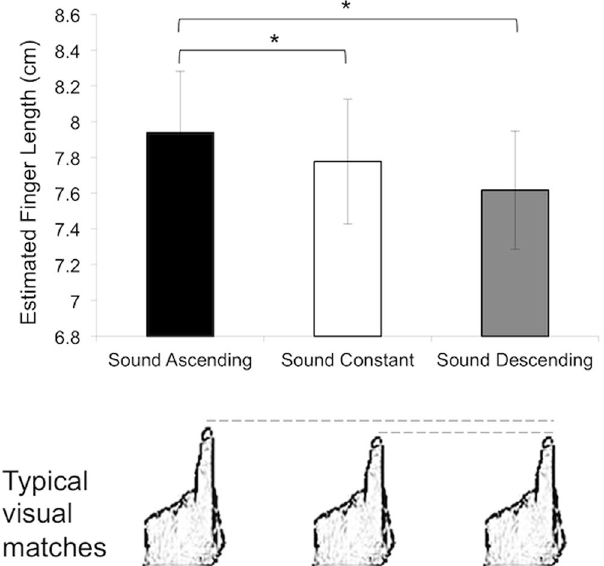
Figure 2. Results of Experiment 1: Mean ( ± s.e.m.) estimated finger lengths as a function of condition in Experiment 1 (N = 24). The asterisk indicates significant differences between sound conditions ( p < 0.05, corrected for multiple comparisons). Participants provided larger finger length estimates for the ‘ascending’ sound, compared with the ‘descending’ sound and with the ‘constant’ sound. The bottom panel displays finger drawings chosen by participants to describe the subjective feeling of their finger when listening to the sound (the drawing closest to the mean choice is displayed as a function of condition). Participants selected significantly longer visual matches to their index finger after the ‘ascending’ sound as compared to the ‘constant’ and ‘descending’ sounds. Drawings in bottom panel are reprinted from Current Biology, 15(14), de Vignemont, F., Ehrsson, H. H. & Haggard, P., Bodily Illusions Modulate Tactile Perception, 1286-1290, Copyright (2005), with permission from Elsevier.